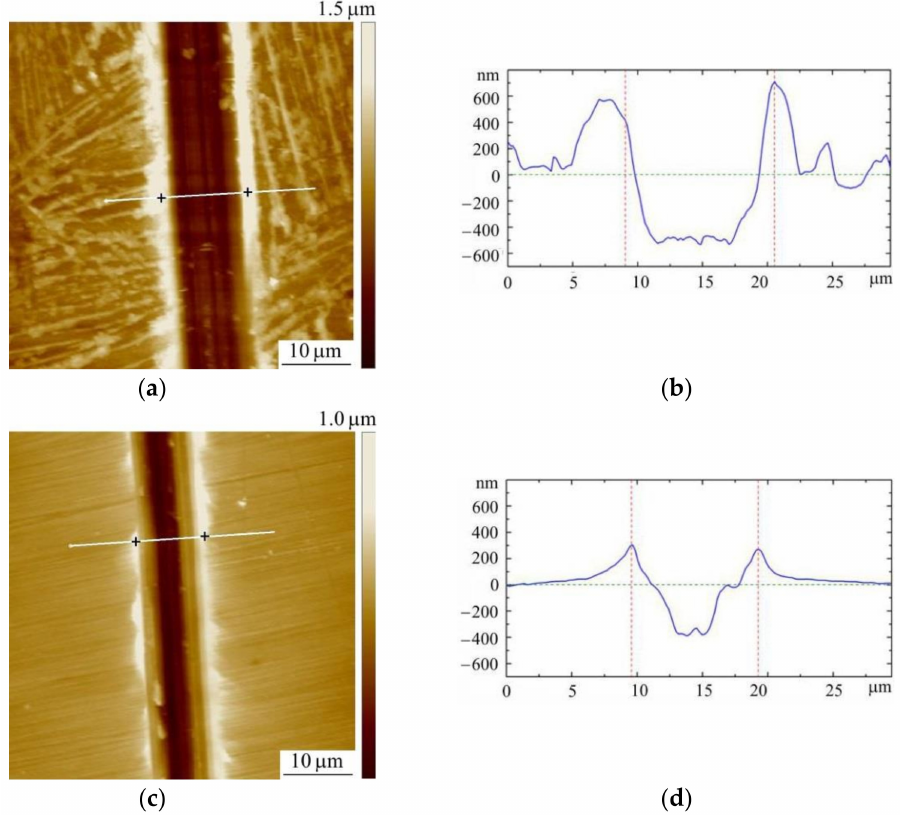
Figure 6. AFM images ( a , c ) and corresponding cross-sectional surface profiles ( b , d ) of scratch grooves formed in the wrought ( a , b ) and EBAM ( c , d ) Ti-6Al-4V